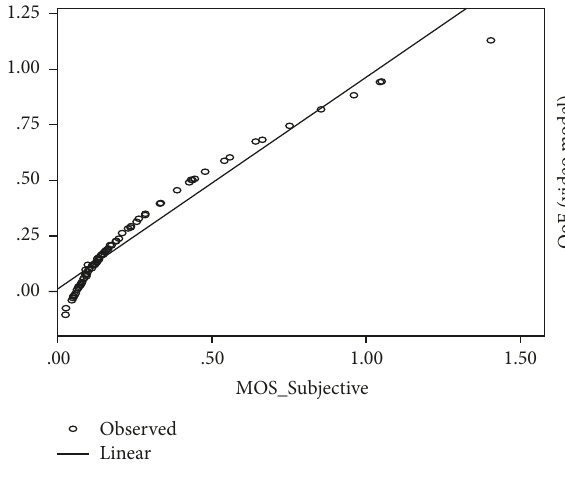
Figure 19: Accuracy of final video model.